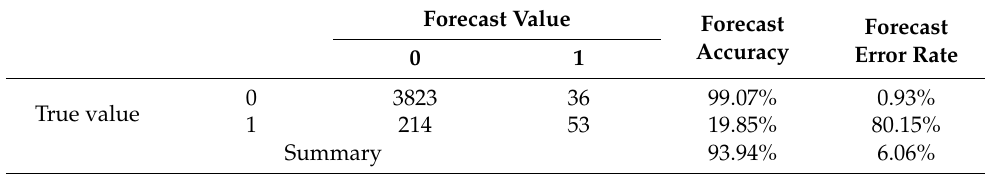
Table 22. Binary logistic regression prediction accuracy